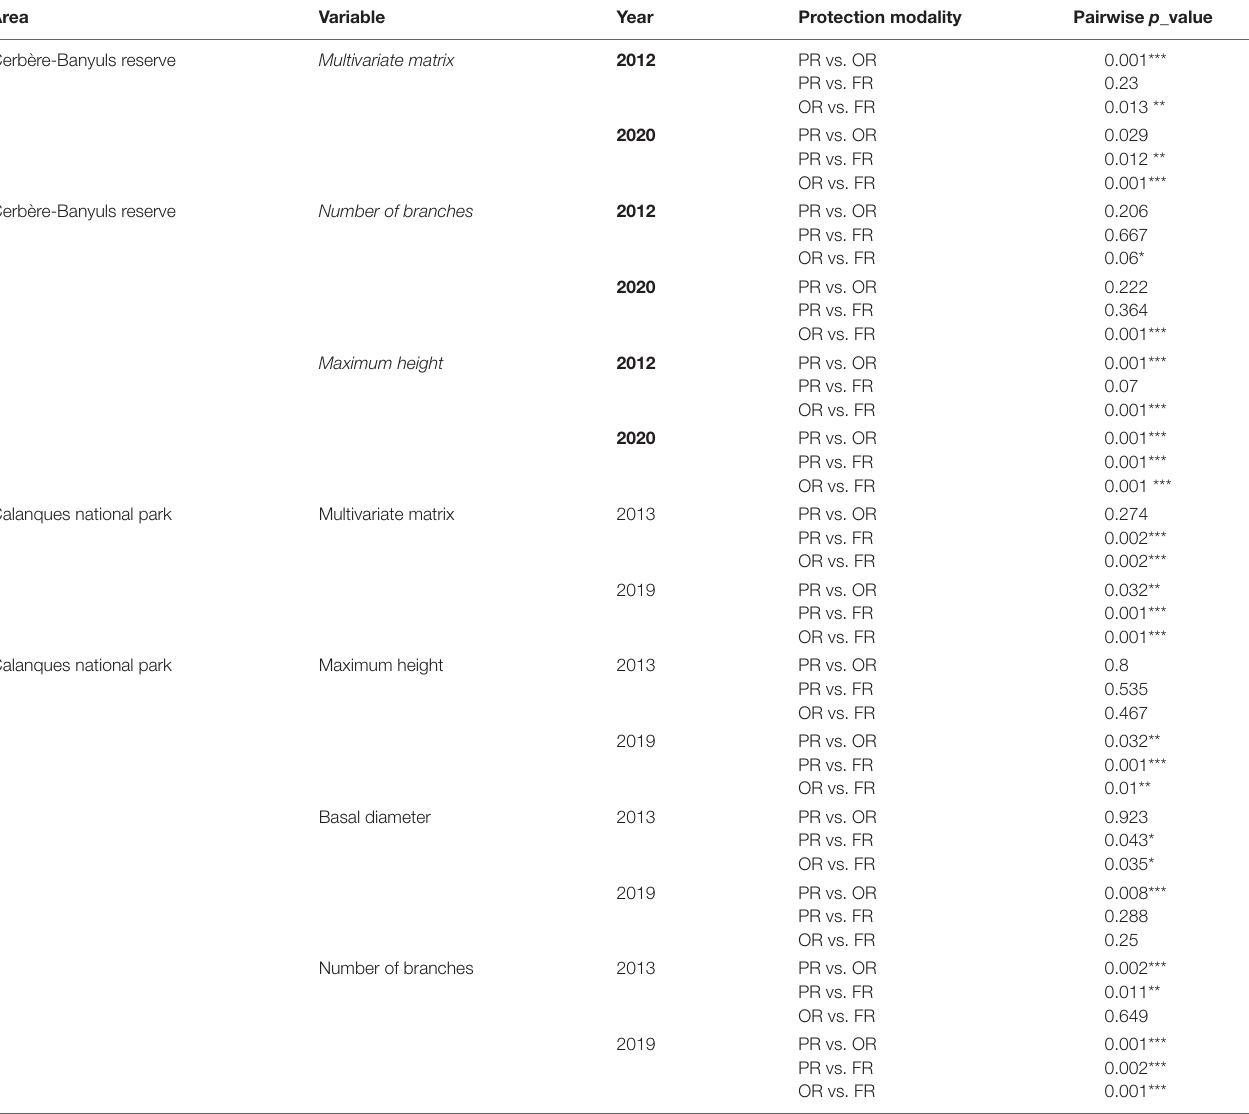
TABLE 5 | Pair-Wise test result corresponding to the interaction between year and protection for the 3